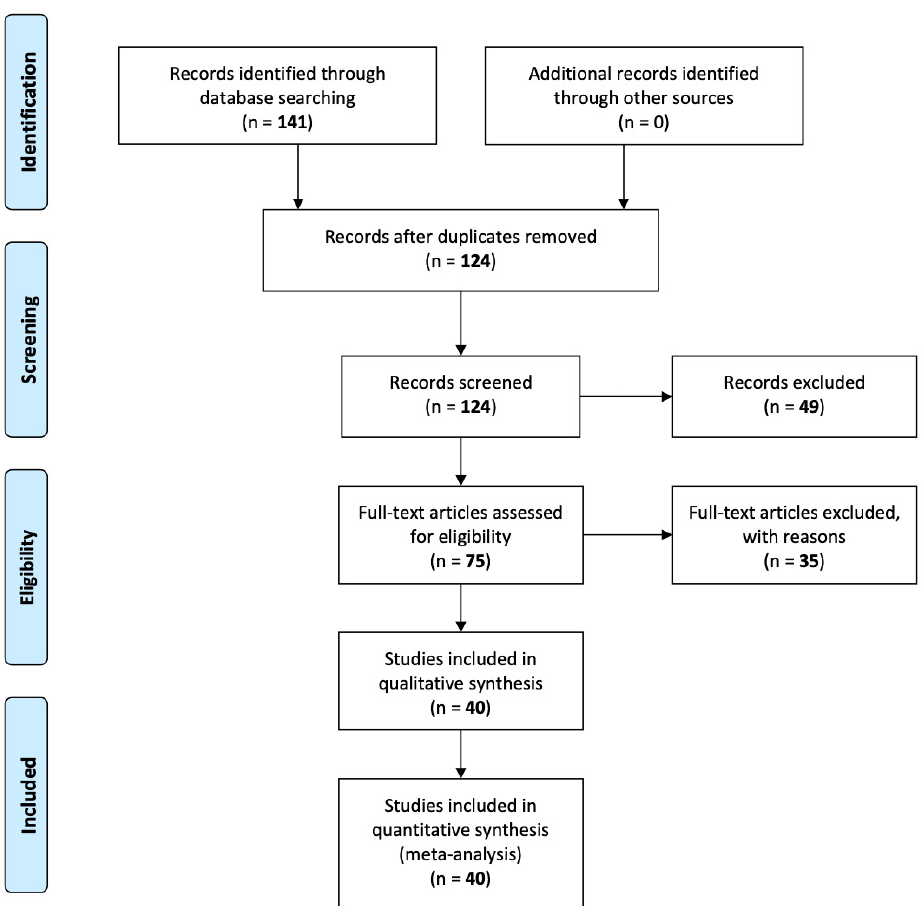
Figure 3. PRISMA flow diagram for systematic